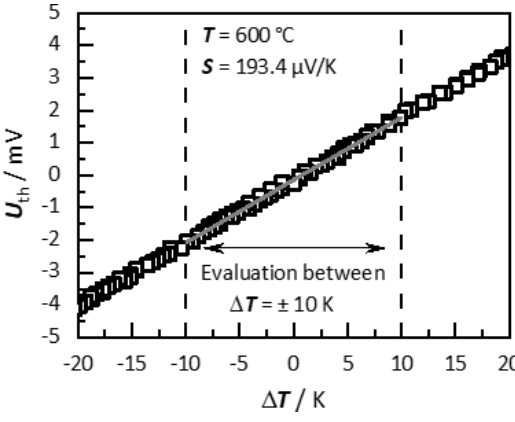
Figure 9. Raw data of a measurement of the Seebeck coefficient of samarium-doped calcium manganate at 600 ◦